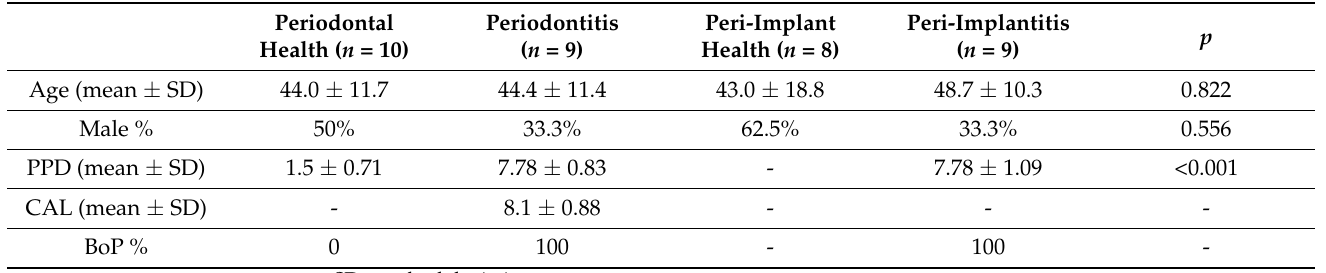
Table 1. Age, gender and site-specific clinical variables (probing depth (PPD), clinical attachment level (CAL) and bleeding on probing (BoP) values) according to